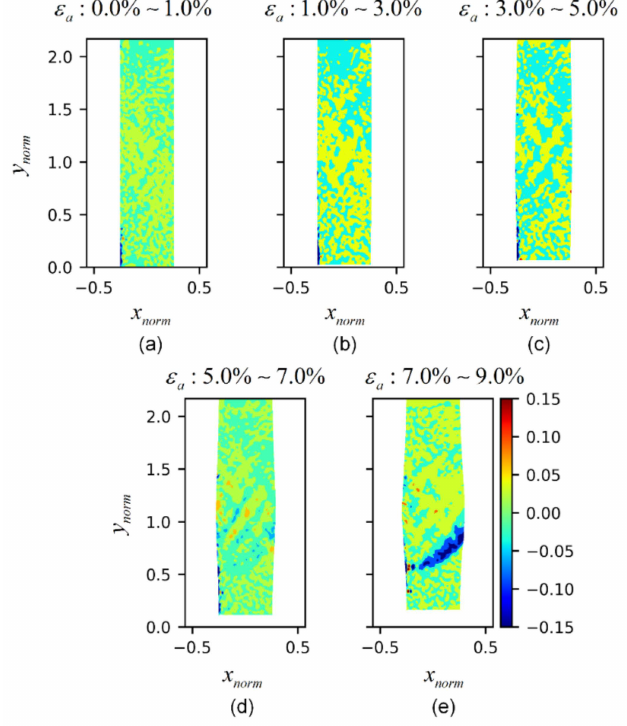
Figure 14. Evolution of curl along ˆ ρ axis ( curl U ) of test 121304d: ( a ) axial strain 0.0%–1.0%; ( b ) axial ρ strain 1.0%–3.0%; ( c ) axial strain 3.0%–5.0%; ( d ) axial strain 5.0%–7.0%; ( e ) axial strain